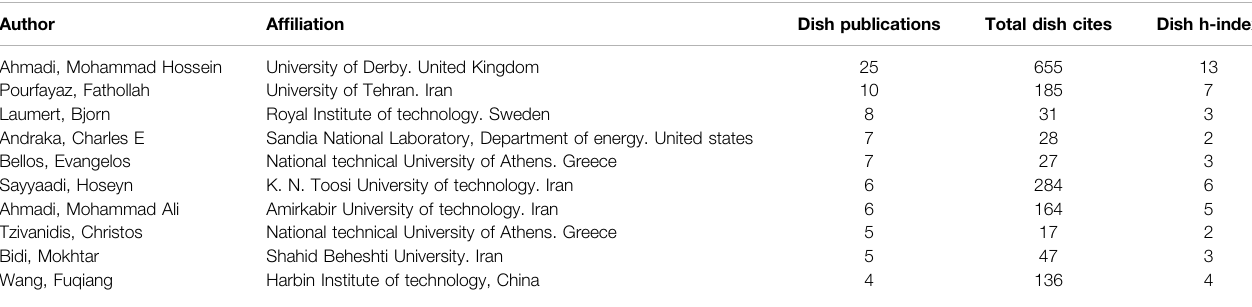
TABLE 14 | Top 10 authors in Stirling Dish fi